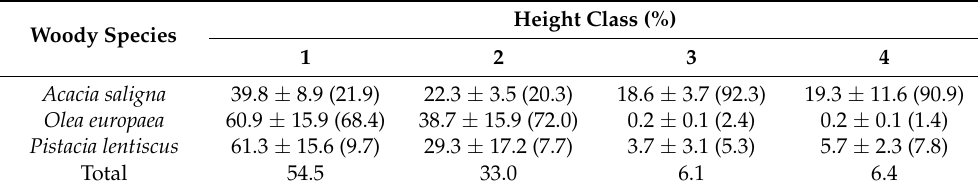
Table 2. Distribution in height class (%) of the woody species regeneration. The relative contribution (%) of each species to each height class is reported within round brackets. Means are followed by the standard error.